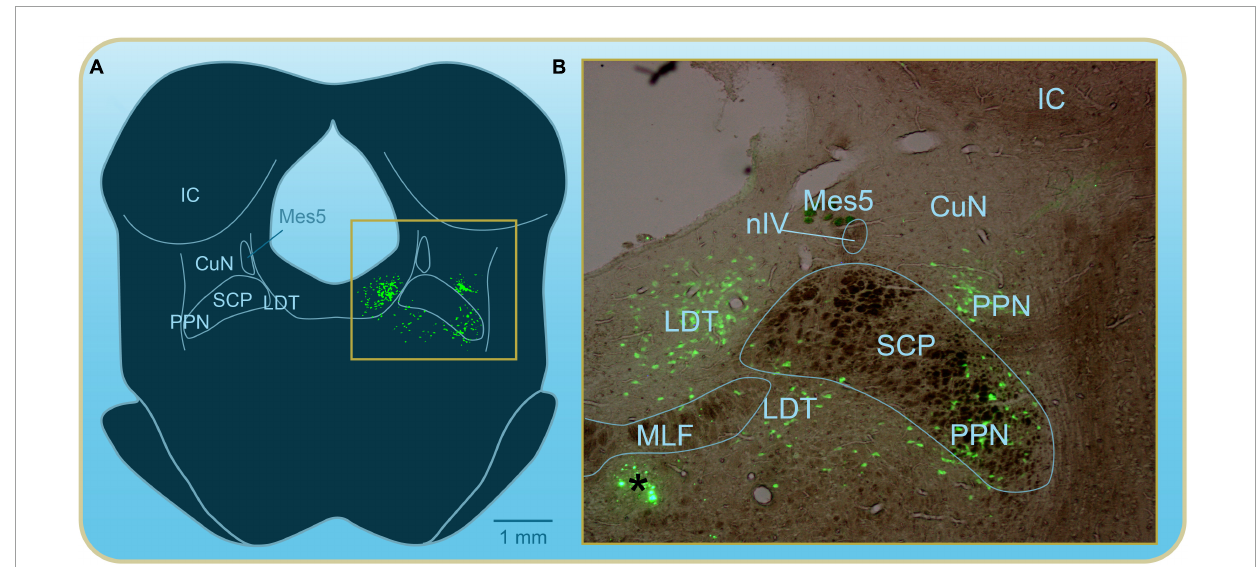
FIGURE2 Mesopontine cholinergic cell populations have been described in the brainstem of mammals many decades ago. Here in the rat, much like in lampreys, the cells are arranged in a nearly continuous fashion but have been grouped into nuclei by neuroanatomists for simplicity. The exact names given to each of these nuclei somewhat vary from one species of mammal to the next. The CuN and PPN are traditionally associated with the MLR. (A) Schematic representation of a cross section of the isthmic region from the rat brainstem showing the mesopontine cholinergic cell populations (green) in reference to other landmarks in the region. (B) Overlay of brightfield and epifluorescence photomicrographs illustrating the cholinergic cells area labeled by immunofluorescence against the enzyme choline acetyltransferase. A black asterisk in the left bottom part of the illustration indicates immunofluorescence artifacts. The frame in panel (A) corresponds to the photographed area. CuN, cuneiform nucleus; IC, inferior colliculus; LDT, laterodorsal tegmental nucleus; Mes5, mesencephalic root of the trigeminal nerve; MLF, medial longitudinal fasciculus; nIV, trochlear nerve; SCP, superior cerebellar